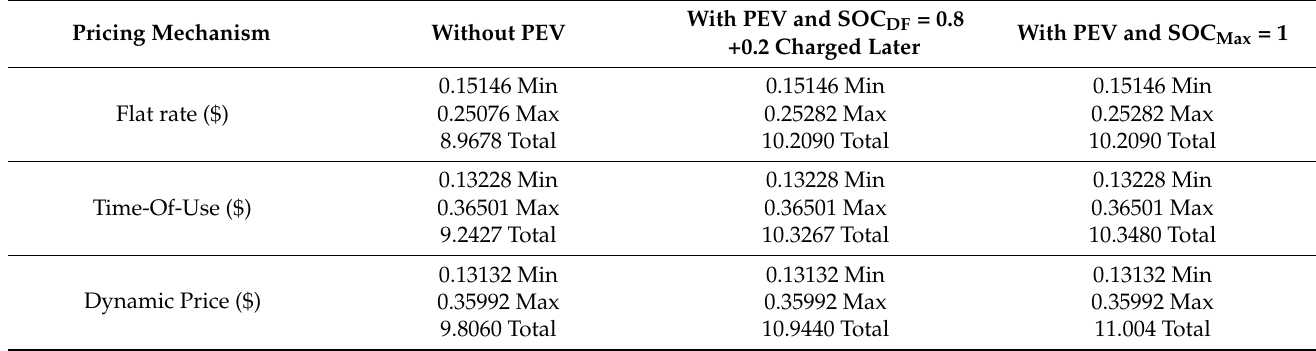
Table 4. Energy cost at